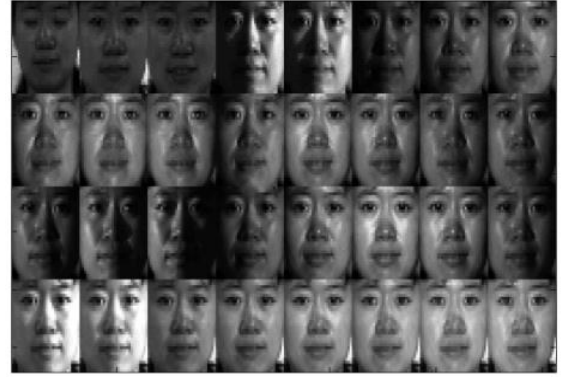
Figure 1. Typical examples of the CMU-PIE dataset.